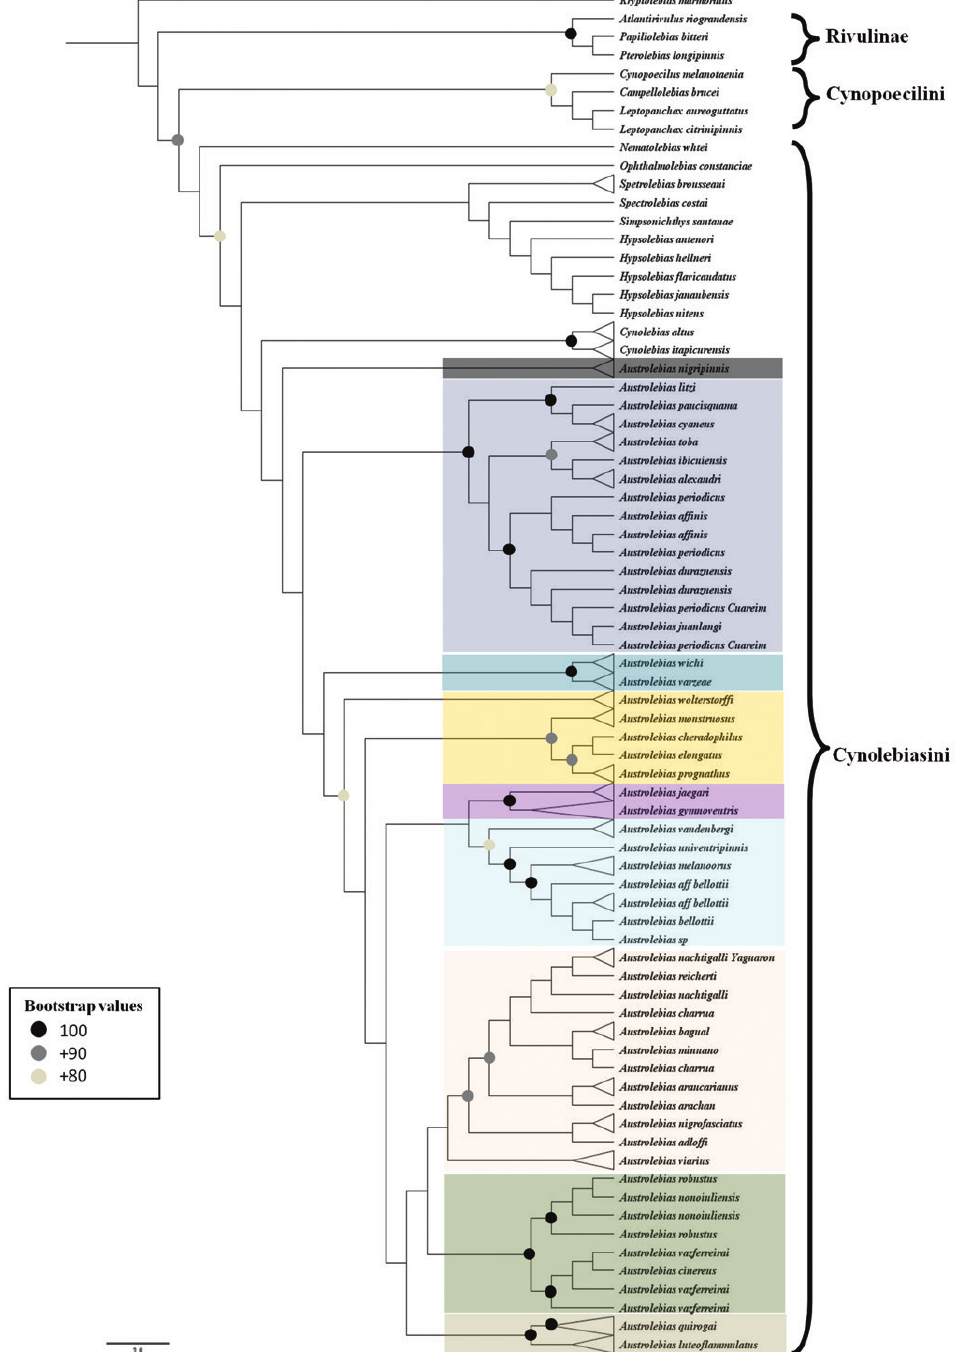
Fig. 9. Maximun parsinony phylogenetic tree of Austrolebias , based on the molecular markers (ribosomal unit 16s, Citochrome b, RAG1, Glyt). Colored areas same as Fig.